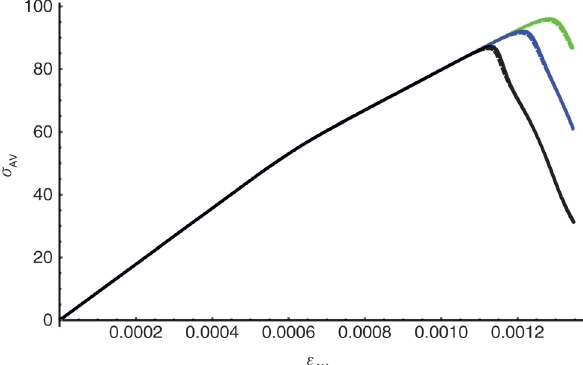
Figure 11: Tension: global stress response for a fast, medium and slow strain rate (green, blue and black), applied to 1024 (dashed), 3136, 6400 and 10,816 elements.